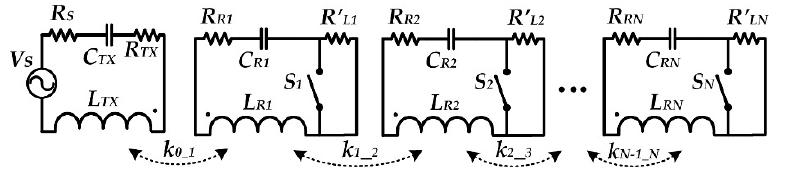
Figure 3. Circuit topology of a power relay system with a transmitter and N receivers [19].